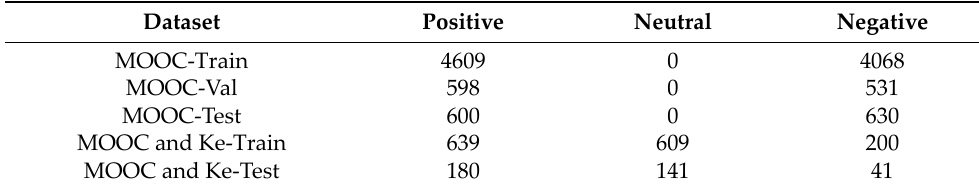
Table 2. Data set distribution.